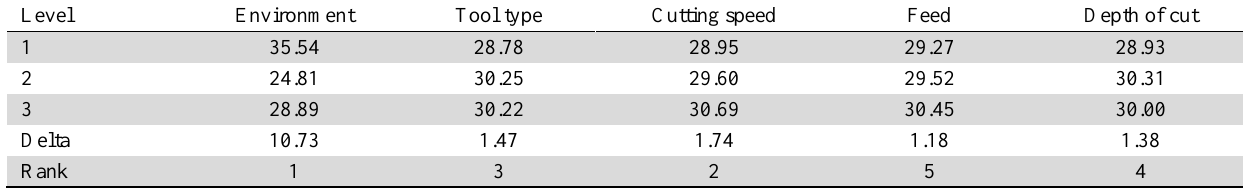
Response Table for Signal to Noise Ratios for Power required for machining (Smaller is better) Level